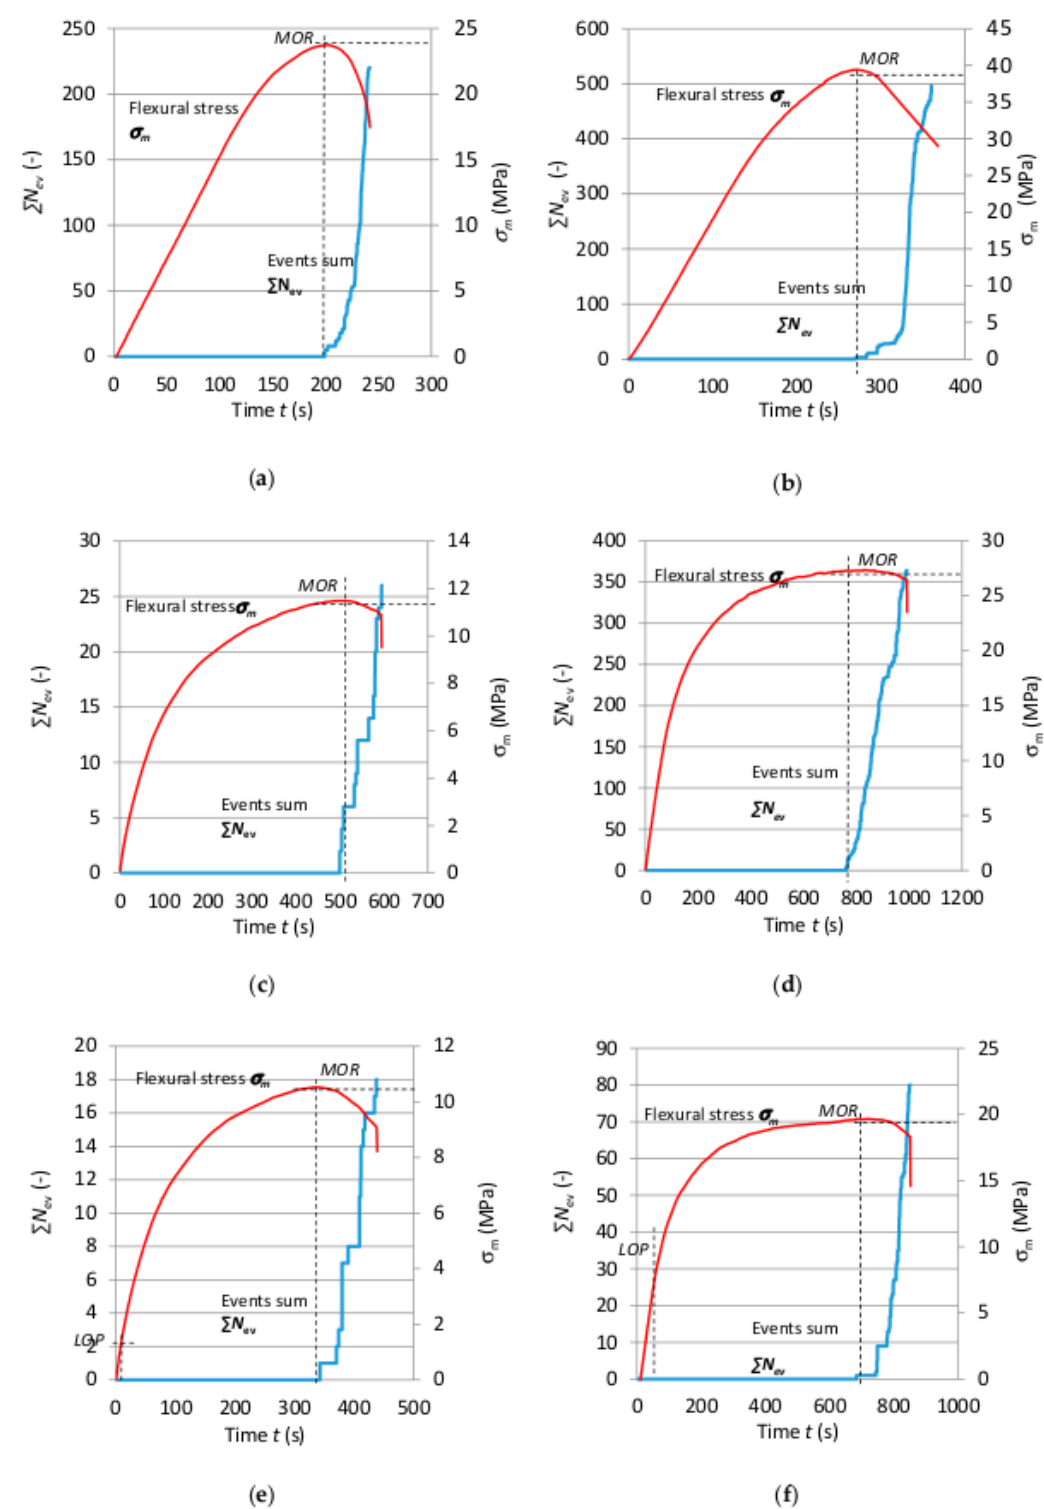
(cid:80) N ev as function of time t for boards of: ( a ) series A R , (cid:80) N ev can be seen